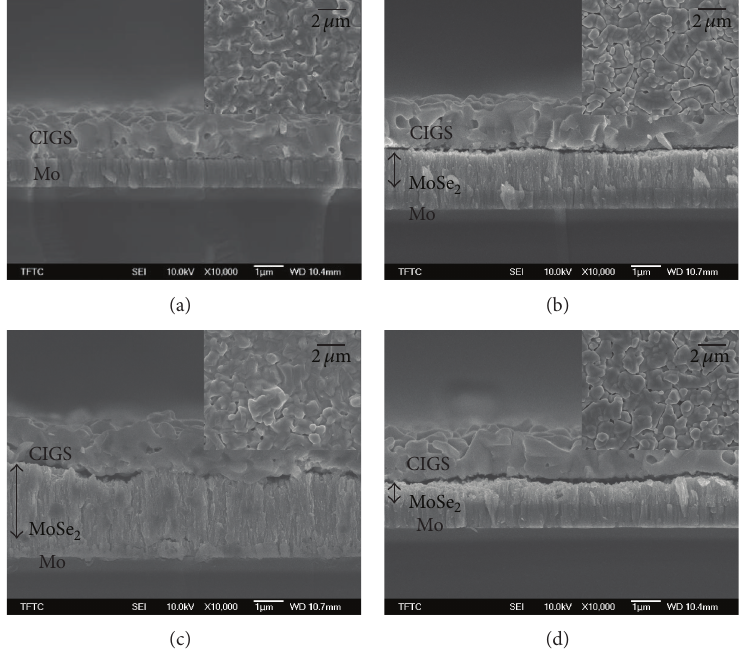
Figure 4: FESEM patterns of CIGS films with various selenization pressures: (a) 48 Pa, (b) 1.02 × 10 3 Pa, (c) 1.45 × 10 4 Pa, and (d) PRV.